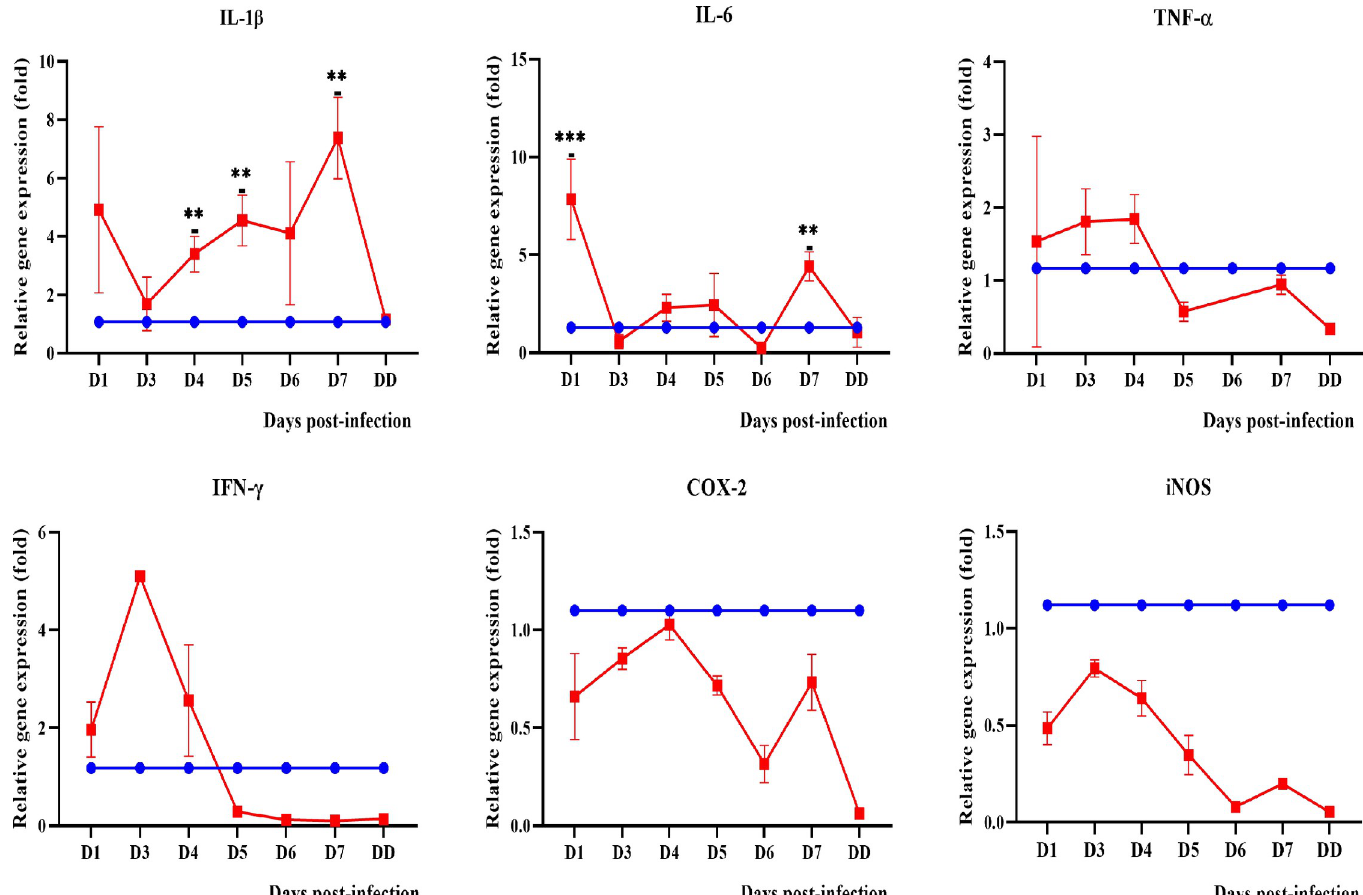
Fig 10. Modulation of pro-inflammatory cytokines and enzymes in the lungs of control (blue line) and infected hamsters (red line). Total RNA was extracted from lungs on day 1 p.i. and days 3 to 7 p.i. D1-D7: Day 1 to day 7. DD: dead. �� P � 0.01, ��� P � 0.001. The fold gene expression value can be found in S2 Table.